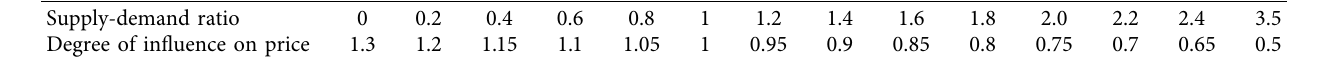
Table 1: Table function of price influencing factor of supply-demand ratio.